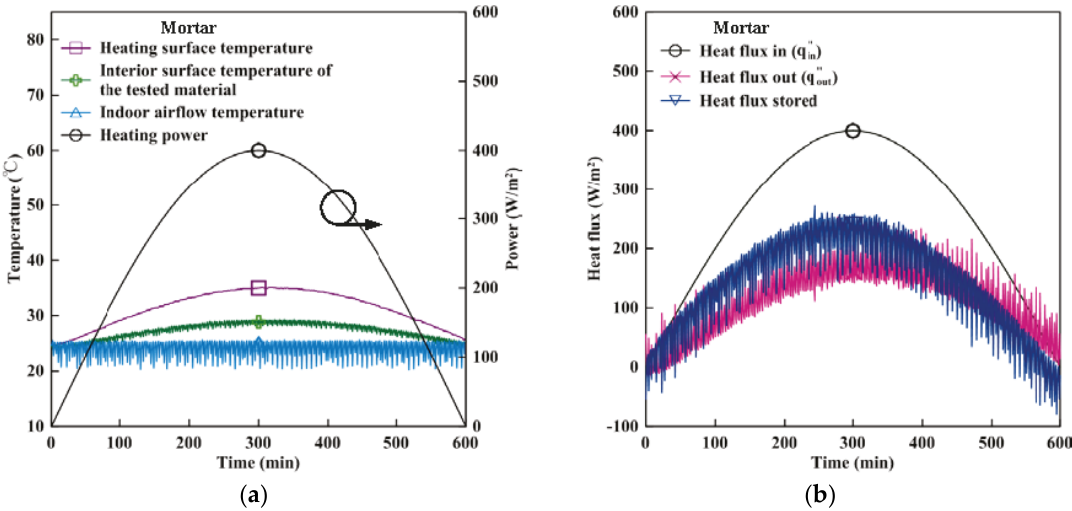
Figure 5. Heat transfer behavior of mortar ( G s,o = 400 W/m 2 ): ( a ) Temperature changes with time; ( b ) Heat flux changes with time.